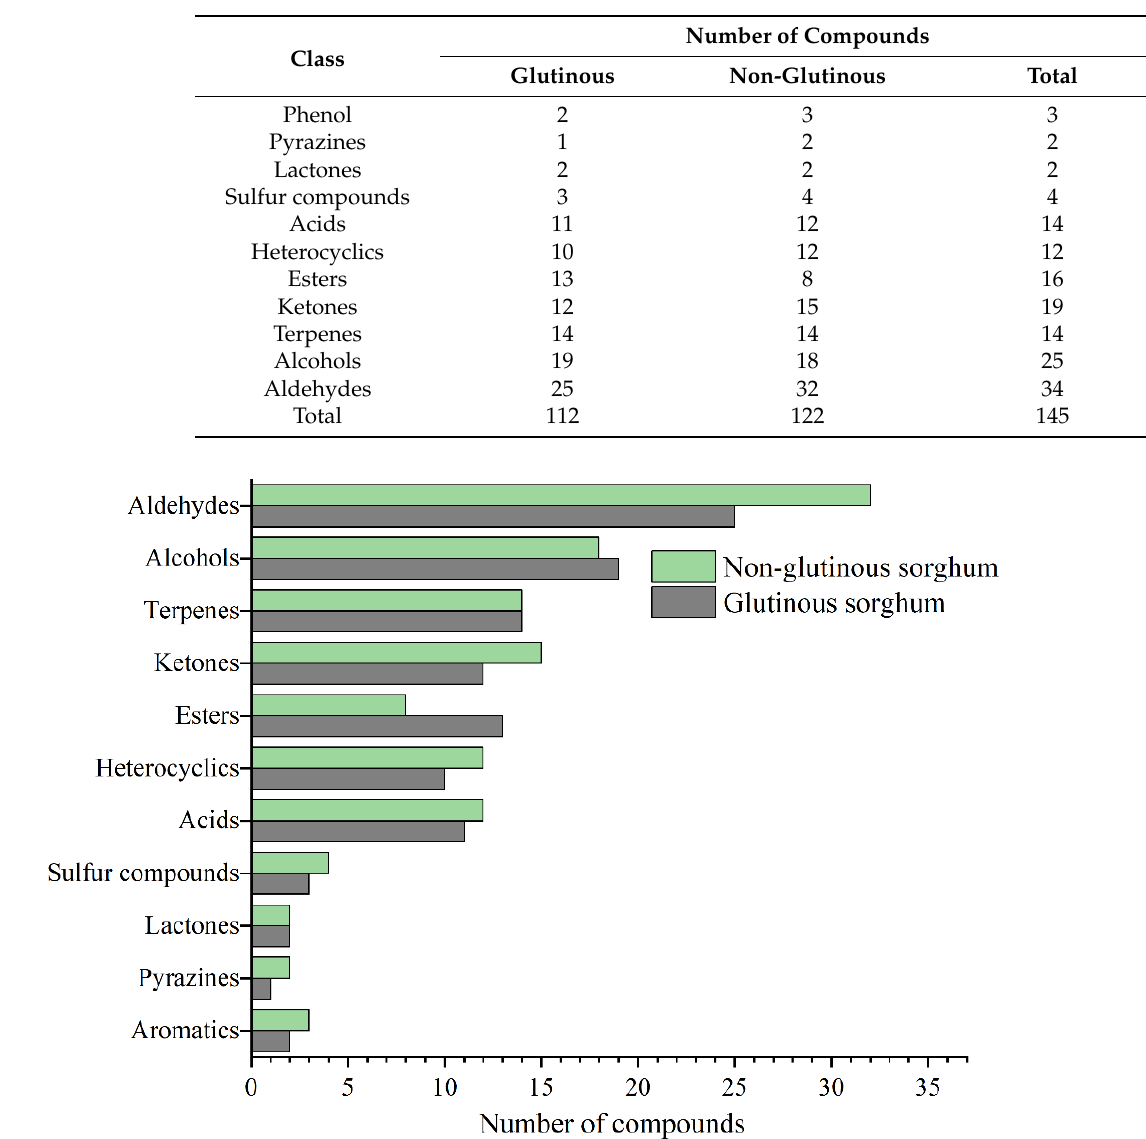
Table 1. Comparison of volatile compounds detected in cooked glutinous and non-glutinous sorghum by HS-SPME-GC × GC-TOFMS.